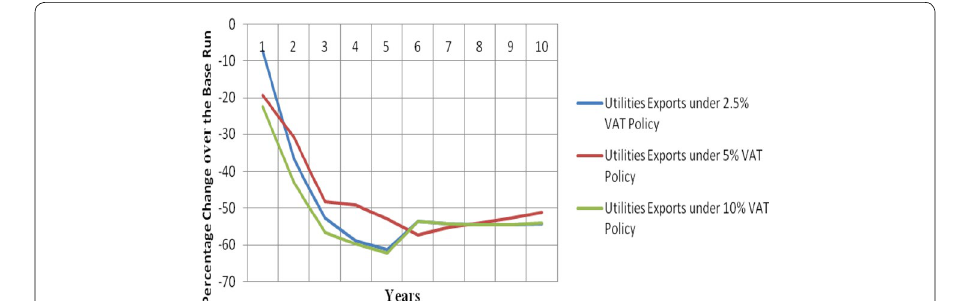
Fig. 47 Changes in utilities exports under varying VAT rates